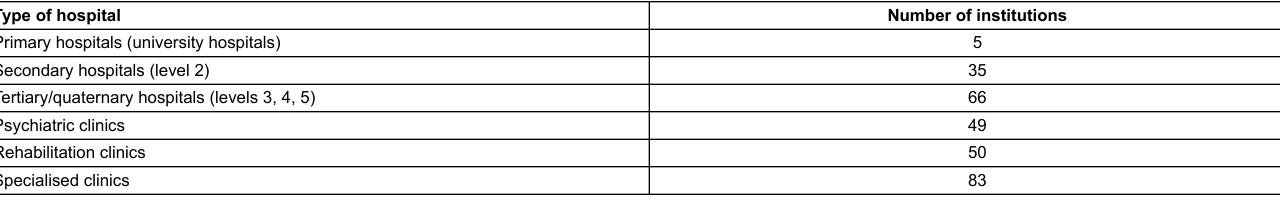
Table 1: Categorisation of inpatient institutions in Switzerland in 2015. Type of